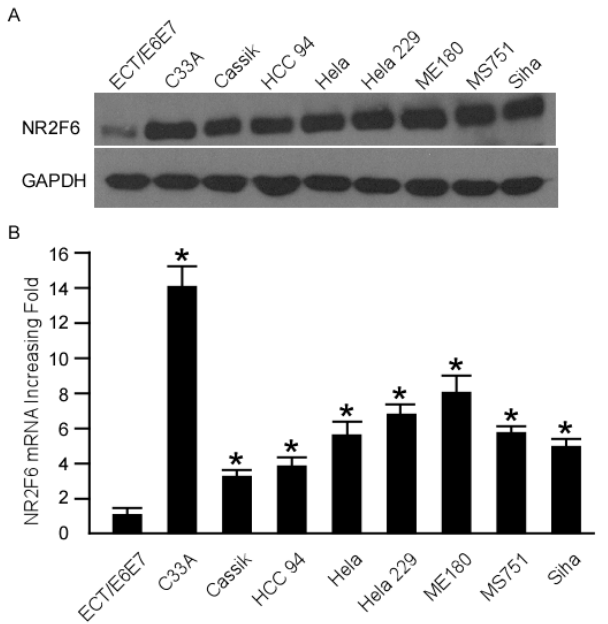
Figure 1. NR2F6 (nuclear receptor subfamily 2 group F member 6) mRNA and protein overexpression in cervical cancer cell lines (C33A, CaSSIK, HCC 94, Hela, Hela 229, ME 180, MS 751, Siha) compared with human cervical immortalized squamous cell line Ect1/E6E7. Western blot ( A ) and real-time PCR ( B ) investigation of NR2F6 mRNA and protein expression levels in cervical cancer cell lines and the Ect1/E6E7 cell line. Expression levels were normalized against GAPDH (the housekeeping gene glyceraldehyde-3-phosphate dehydrogenase, internal control). Error bars: standard deviation (SD) of the mean from three parallel experiments. * p < 0.05.